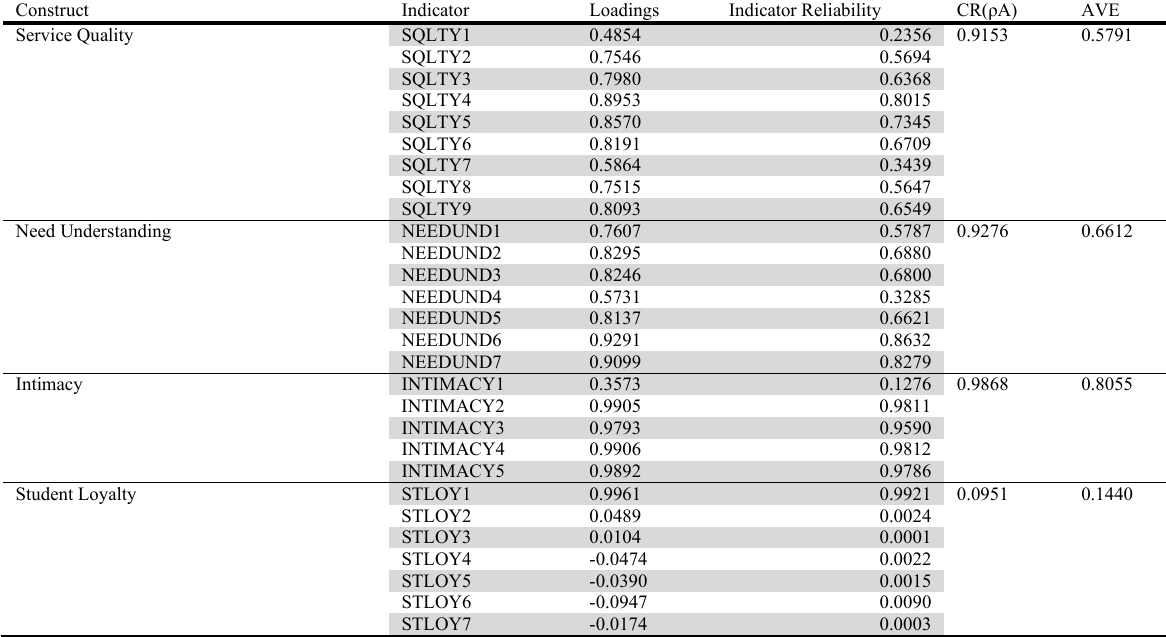
Measurement Model